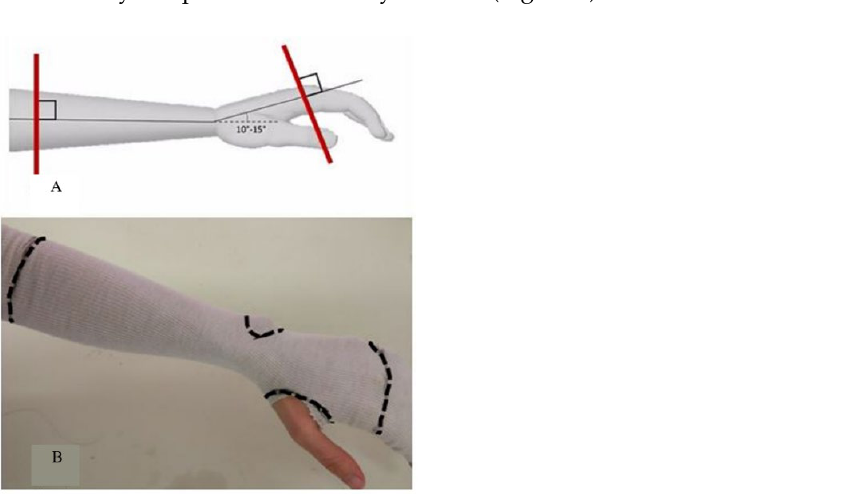
Figure 2. Neutral “thumb-up” position with the wrist in slight extension (10–15°) ( A ). The base of the thumb, the head of the metacarpals and the ulnar styloid positions are then marked by the op- erator ( B ).